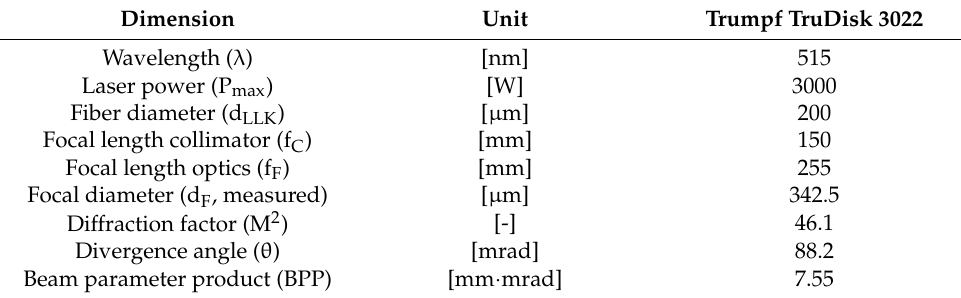
Table 2. Laser beam source and optical setup used for the investigation. Dimension